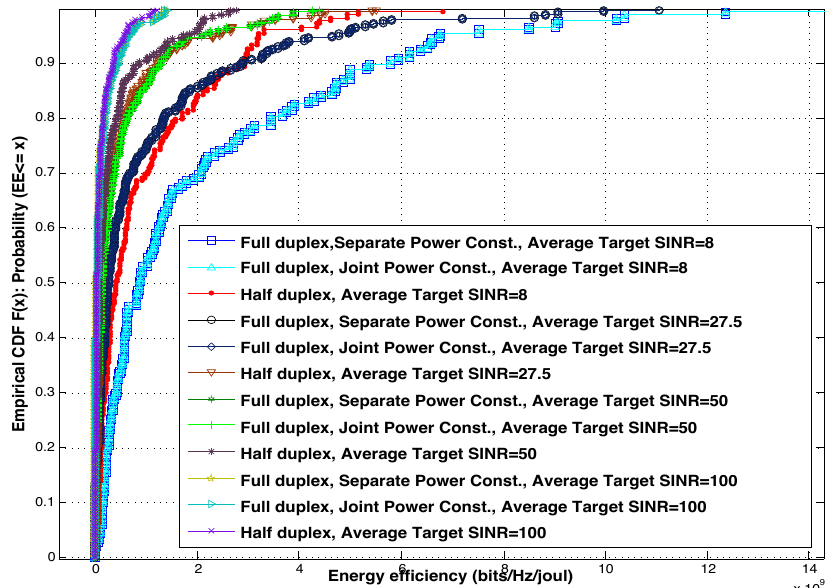
Figure 4. The CDF of the average energy efficiency (EE) of a 36-cell network using different transmission schemes under different average target